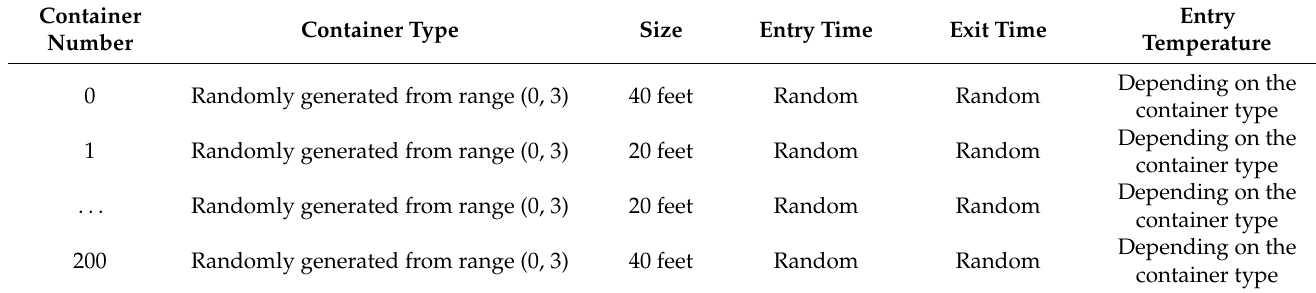
Table 3. Data of Containers.